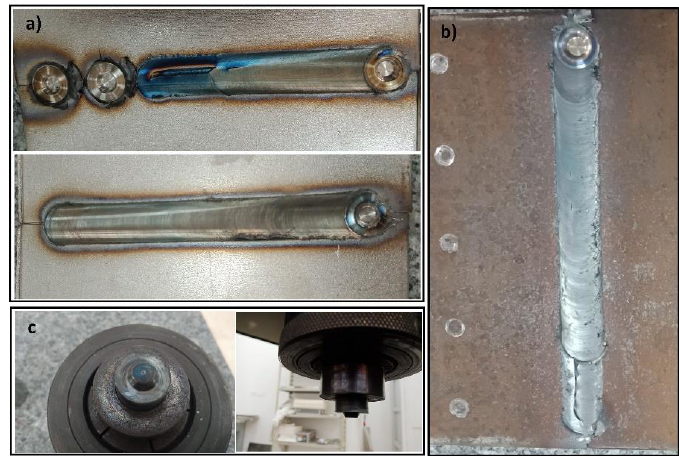
Figure 17. Top views of the welded materials using the produced WC-based composite tool material (WC-Co-TaC-NbC with 2.5 wt% Y 2 O 3 and 5 wt% Ni). ( a ) Ni base alloy, ( b ) carbon steel, ( c ) the FSW tool after several FSW experiments.